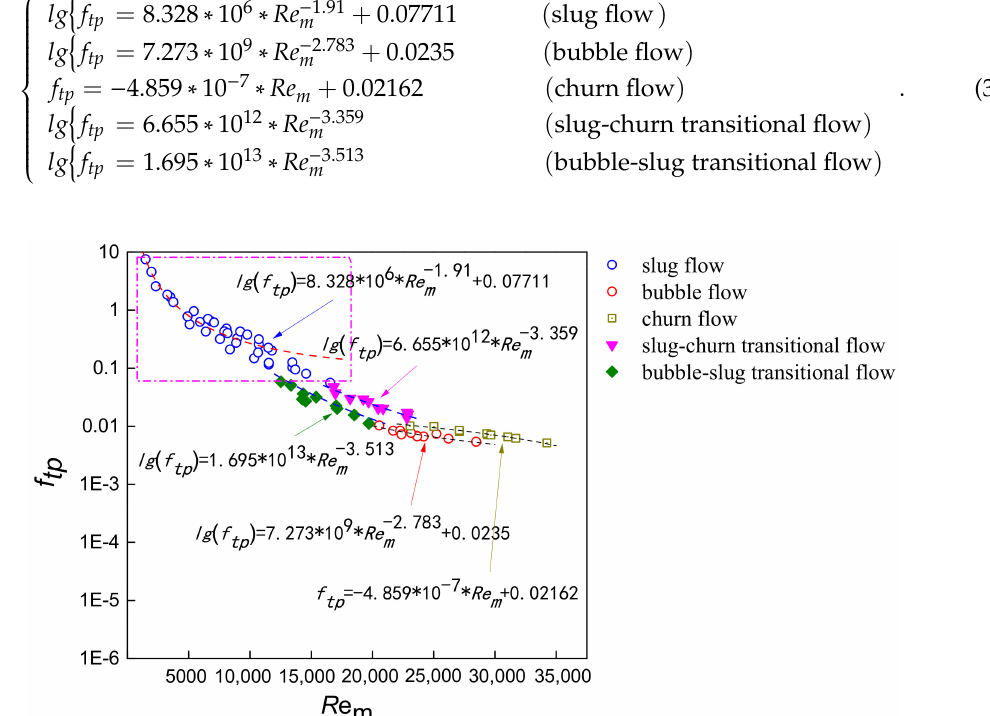
Figure 11. Relationships between experimental friction factor f tp and mixture Reynolds number R em